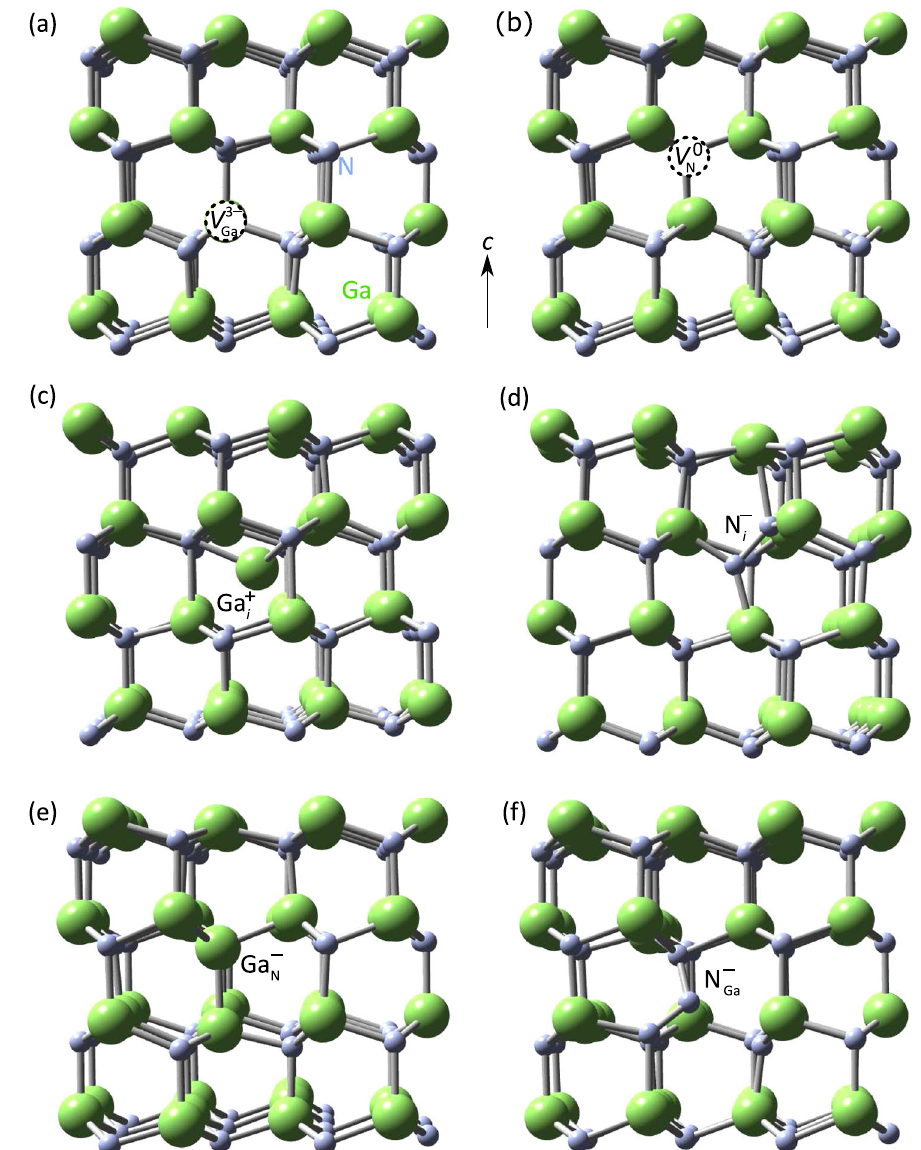
Fig. 1 Con fi gurations of native defects in GaN. a V 3 (cid:2)